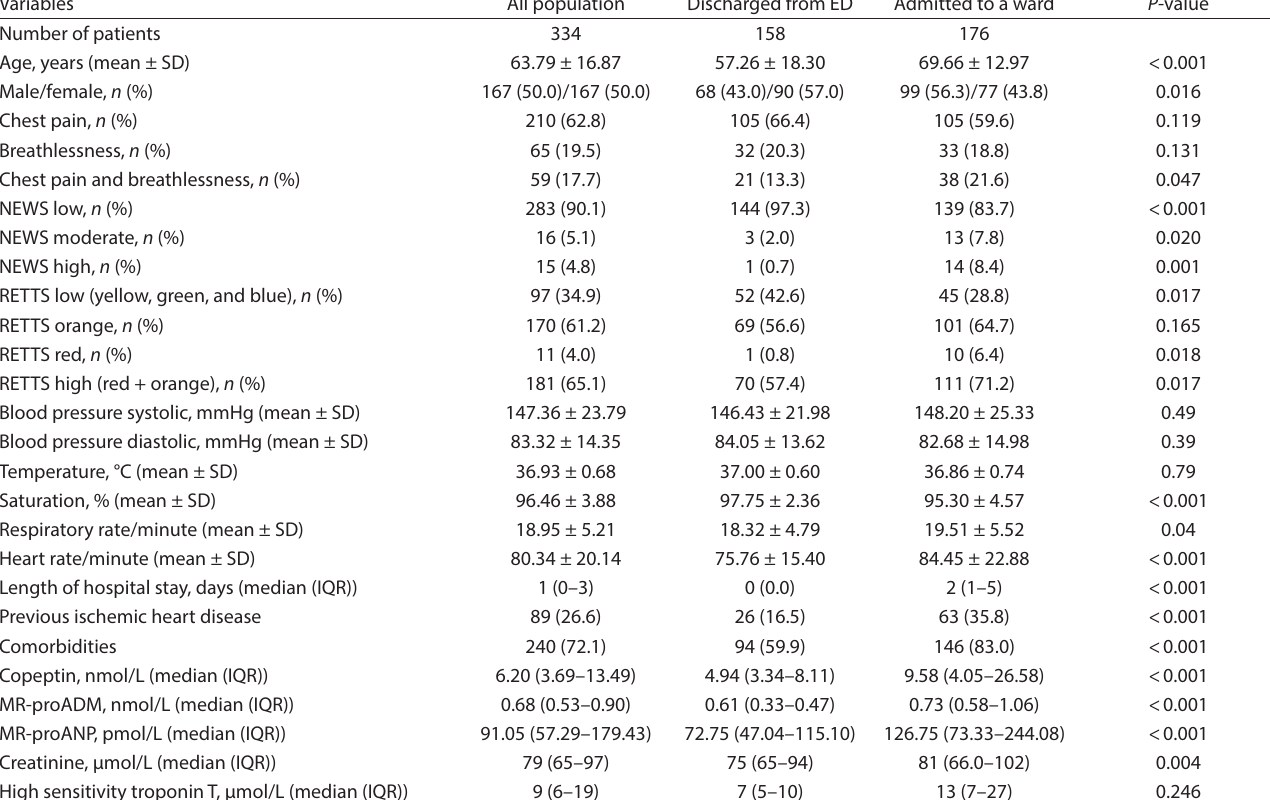
Table 1. Baseline characteristics of the study